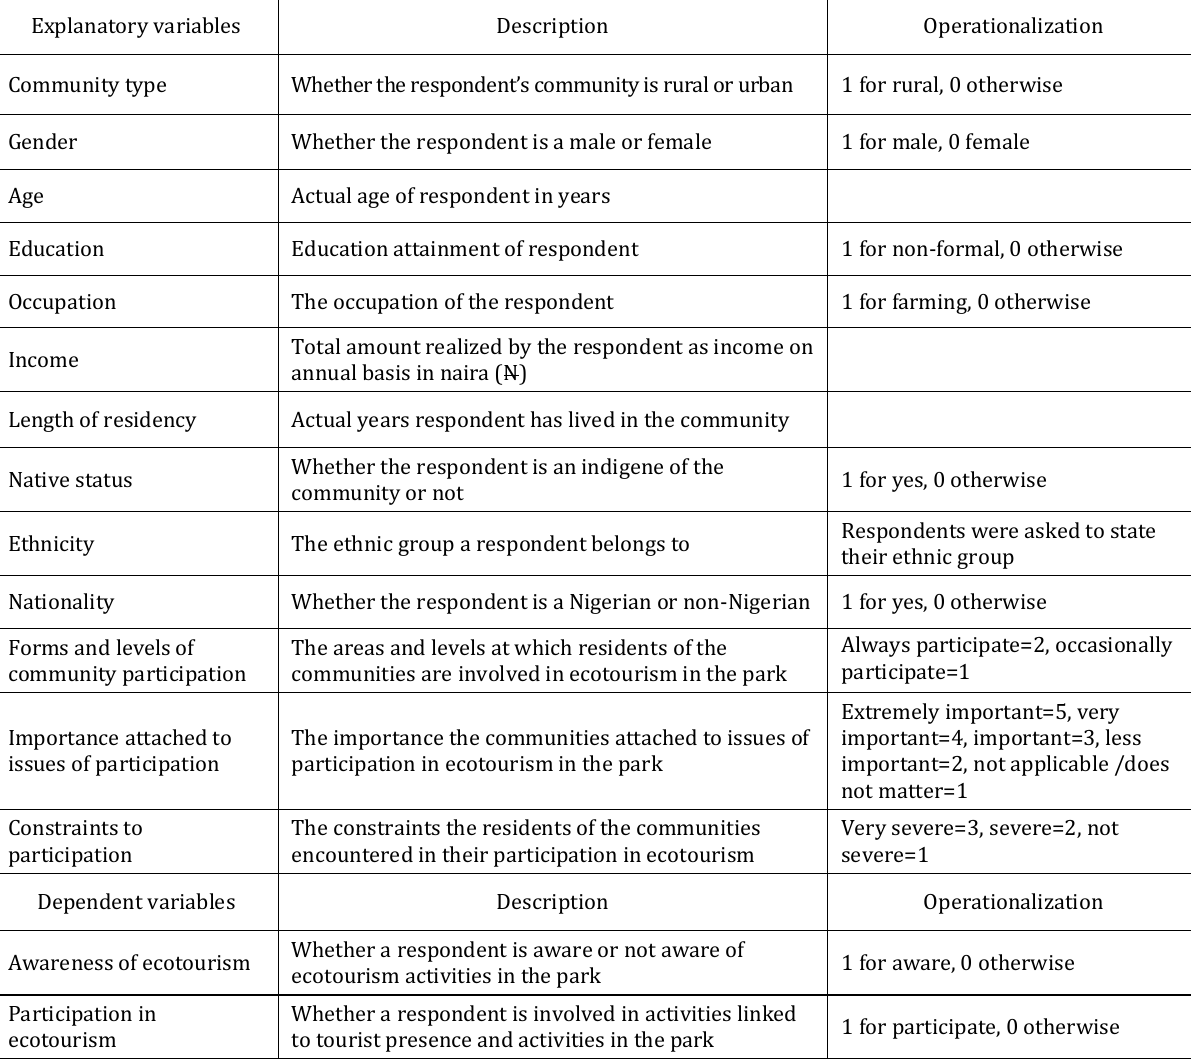
Table 1. Operationalization of